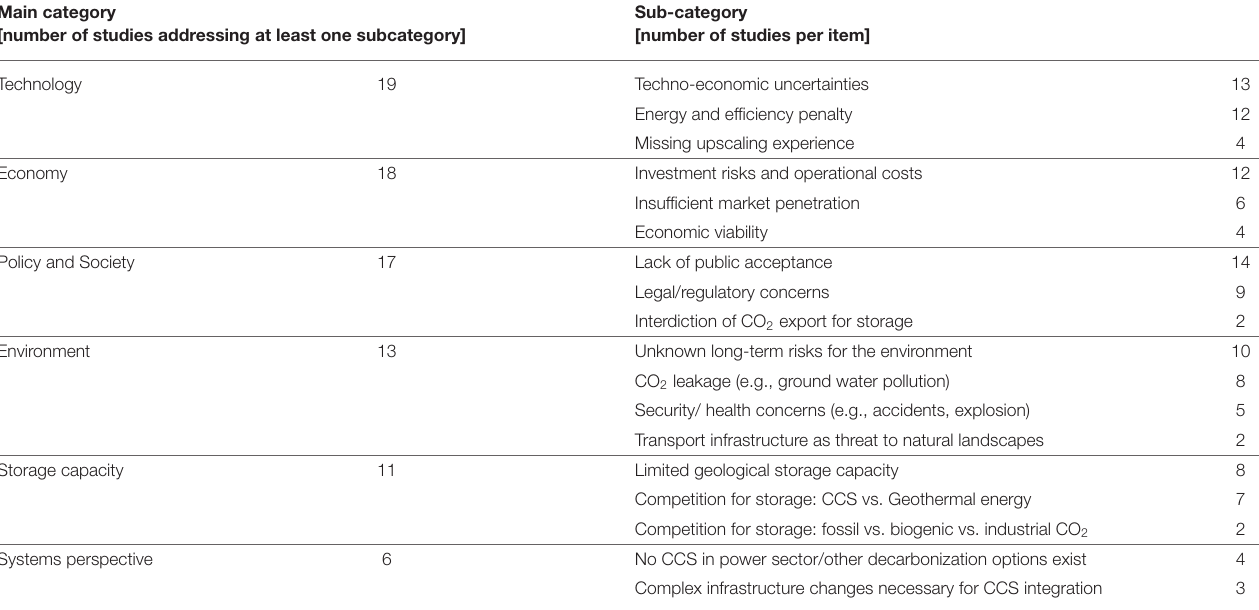
TABLE 2 | Obstacles to (BE)CCS deployment mentioned in German scenarios ( n = 30). Main category [number of studies addressing at least one